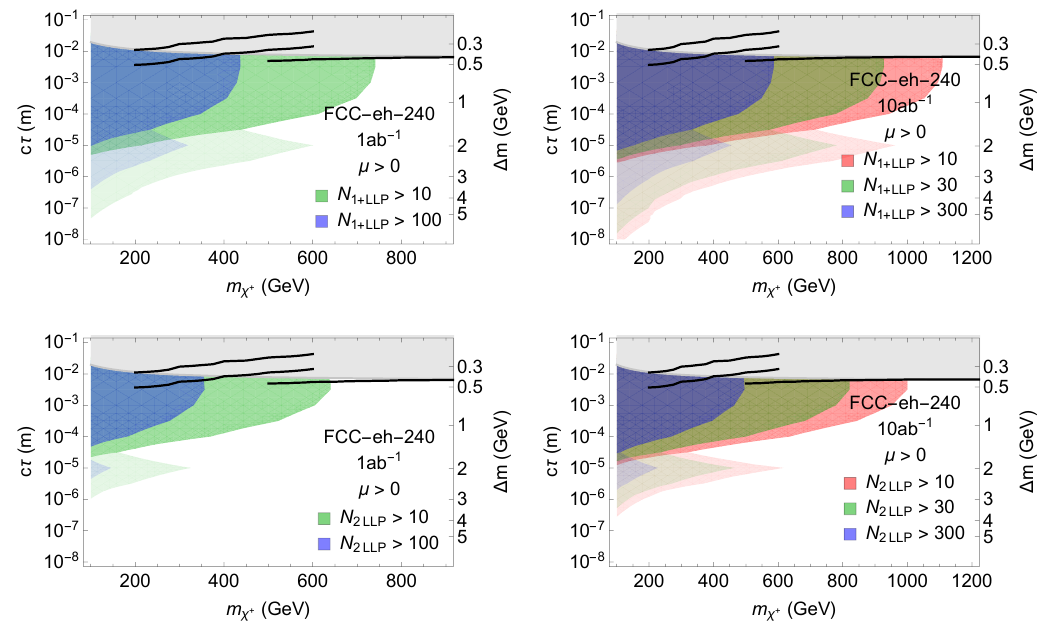
Figure 9 . Same as (cid:12)gure 8 for the FCC-eh with a 240 GeV electron